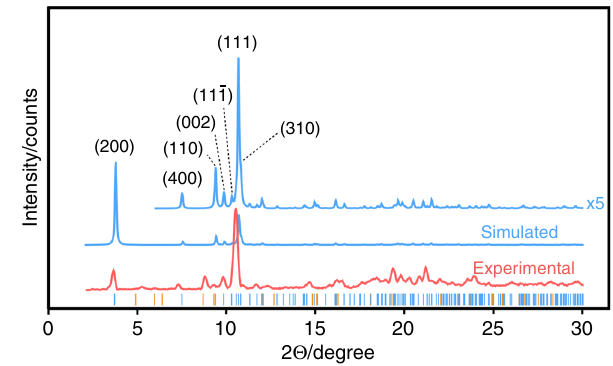
Fig. 3 Experimental and simulated powder X-ray diffractograms of MOF- Fig. 2 Solid-state cyclic voltammetry of MOF-CoNDI-py-2 in MeCN. A CoNDI-py-2 using a Cu source at λ = 1.54 Å. Below the curves are the cavity microelectrode was used as working electrode, a platinum wire as calculated allowed peak positions as black auxiliary and Ag/AgNO 3 (10 mmoldm − 3 , MeCN) as reference, in a 0.1 mol dm − 3 [N( n -Bu) 4 ](PF 6 ) solution in acetonitrile at 50 mV s − 1 . The voltammogram shows characteristic naphthalene diimide reduction pairs at E = − 0.79 and − 1.25 V vs Ag/AgNO 1/2 3 , coupled with the Co(II)/Co(I) pair at − 0.79 V